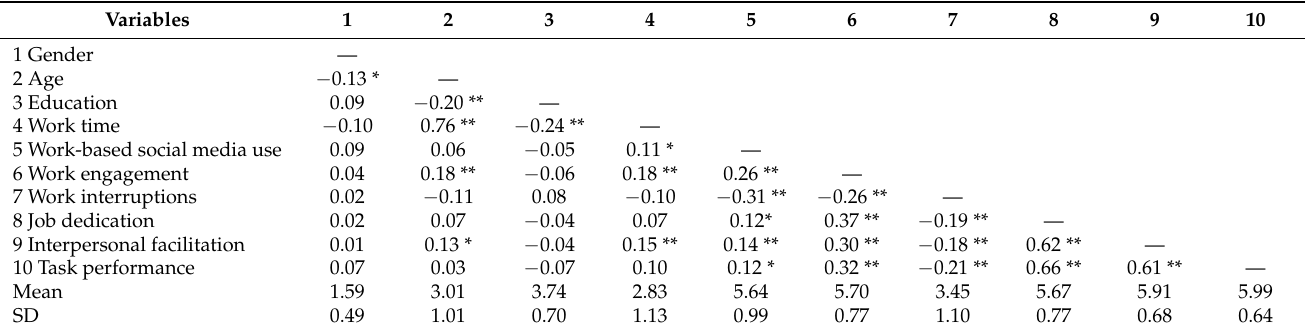
Table 3. Means, standard deviations, and correlations for all included variables.